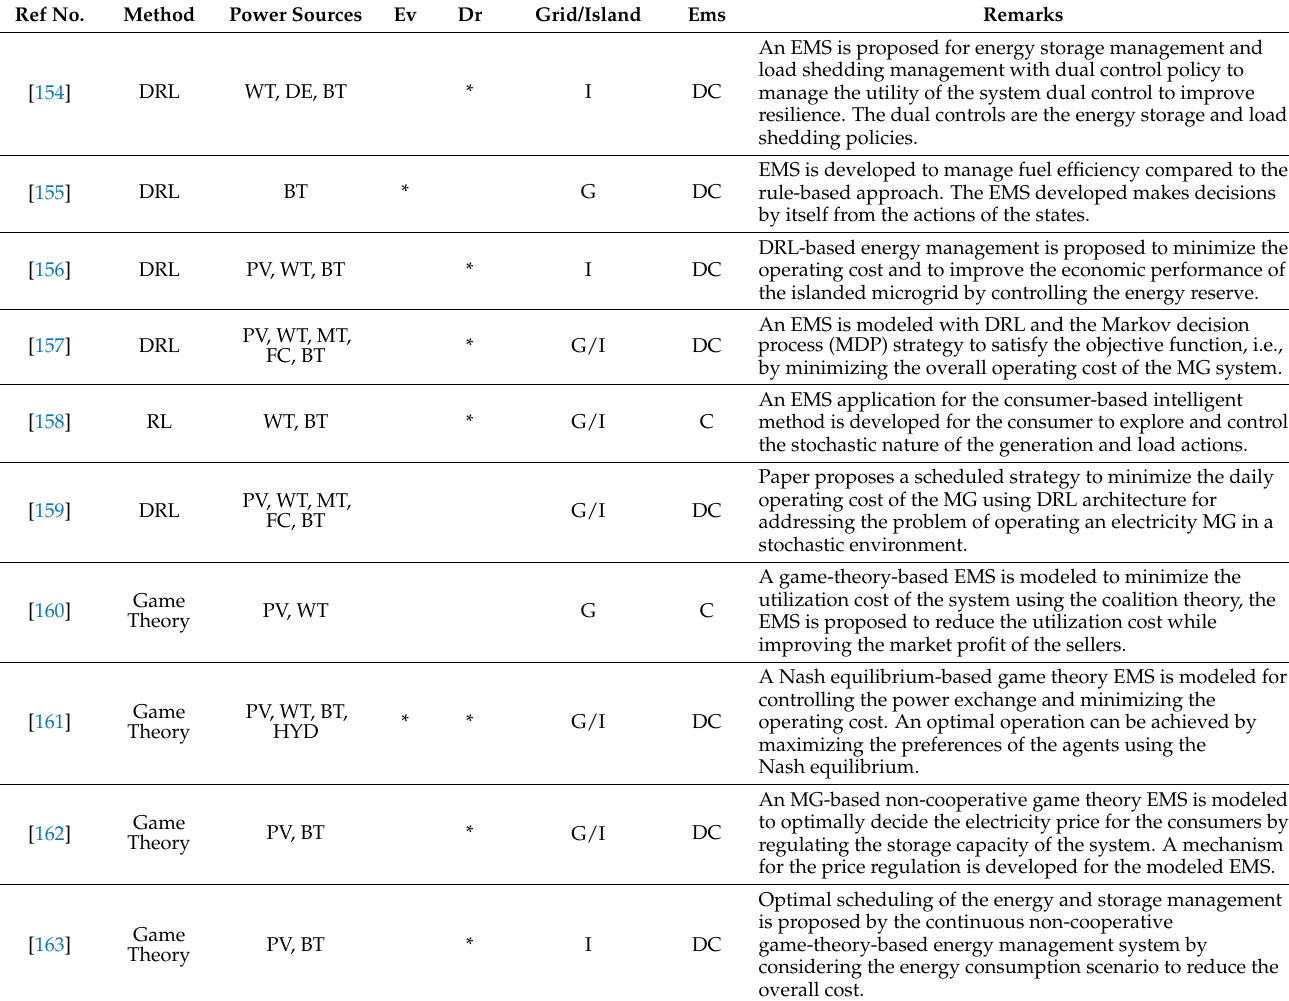
Table 9. A review on game theory and deep reinforced learning in